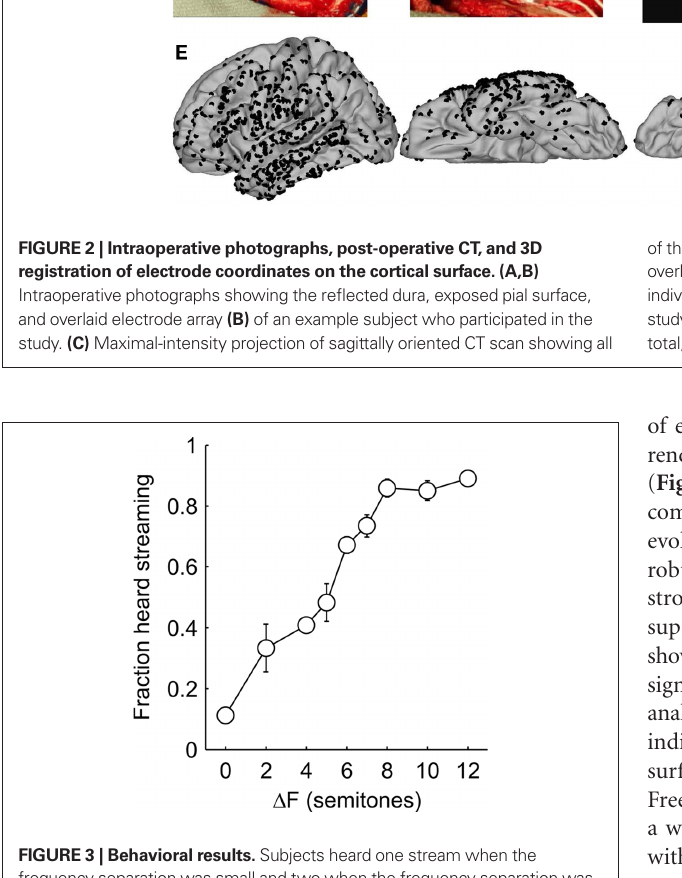
Figure 3 | Behavioral results. Subjects heard one stream when the frequency separation was small and two when the frequency separation was large. Intermediate frequency separations perceptually bistable, i.e., perceived either as one or two streams. Error bars represent the SE of the mean across participants. 1 semitone = 8%